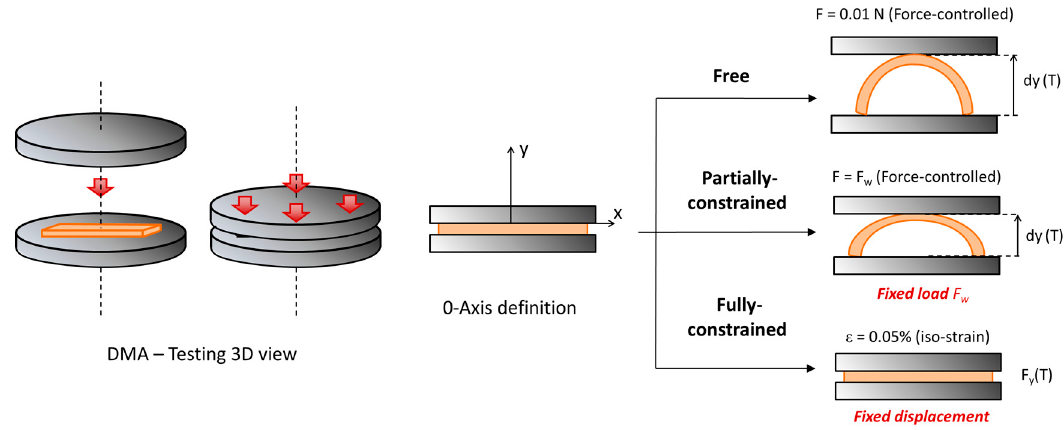
Figure 4. Illustration of the DMA testing procedure including the different recovery scenarios.